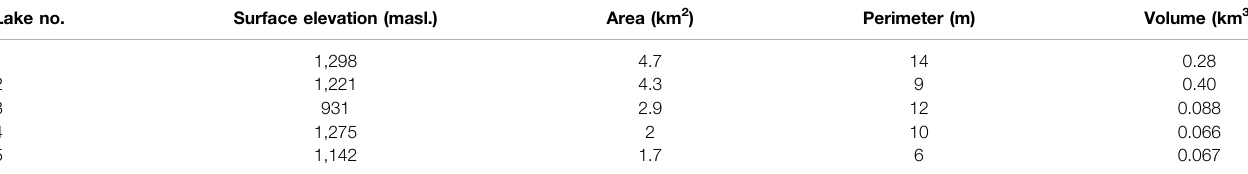
TABLE 2 | Attributes (area, volume and perimeter) for the fi ve largest future forming lakes in the landscape currently covered by Sørfonna ice cap (see the lakes in Figure 7 ). Lake